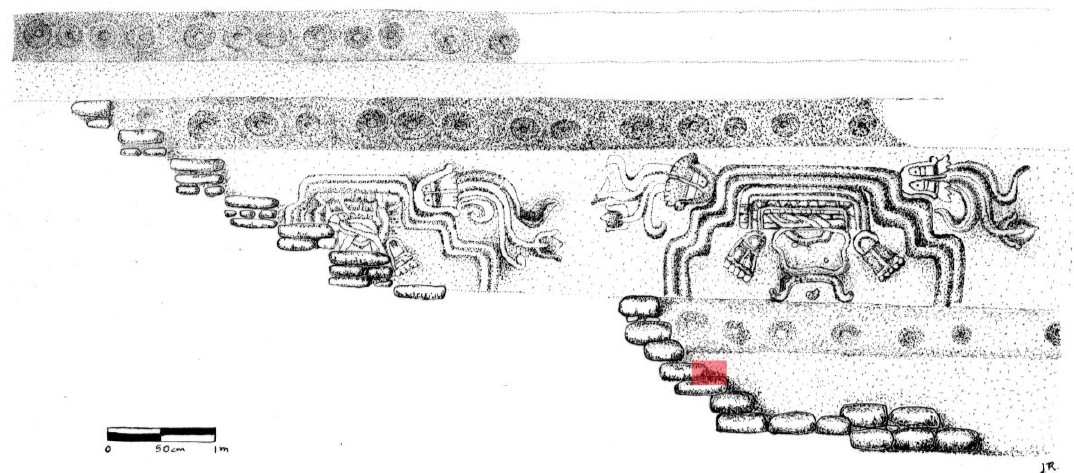
Figure 3. Location of the sample for radiocarbon dating within Structure 2.